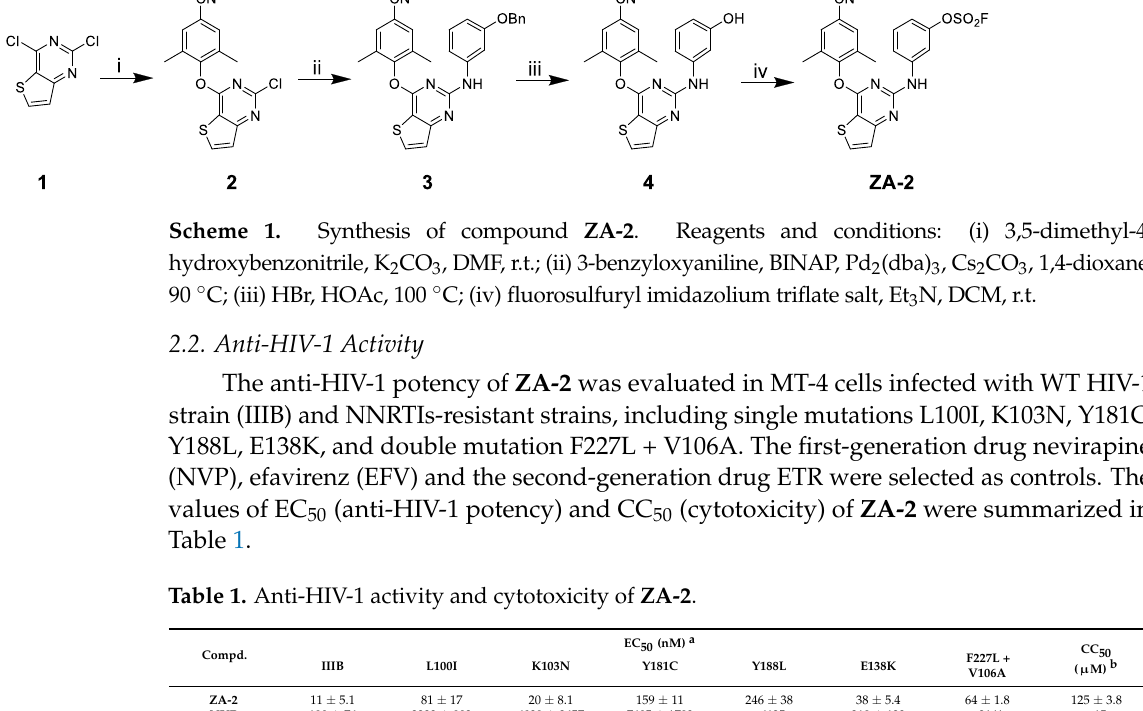
Table 1. Anti-HIV-1 activity and cytotoxicity of ZA-2. Compd.